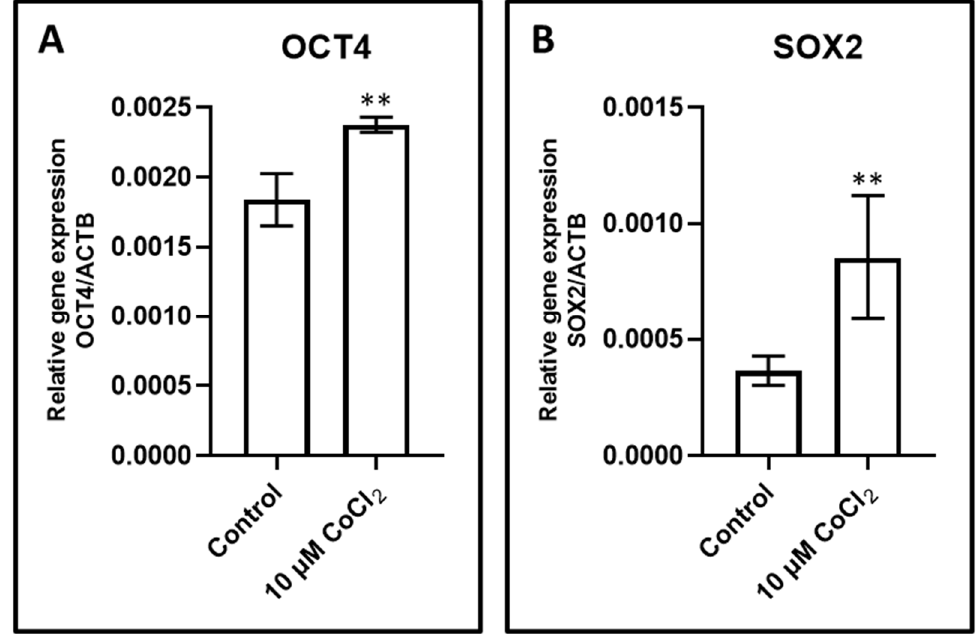
Figure 4. ( A ) : OCT4 levels; ( B ): SOX2 levels. ns not significant, ** p < 0.01. Table 7. Effect of CoCl 2 on stemness related genes OCT4 and SOX2 expression in DPSCs. Relative Gene Expression/ACTB